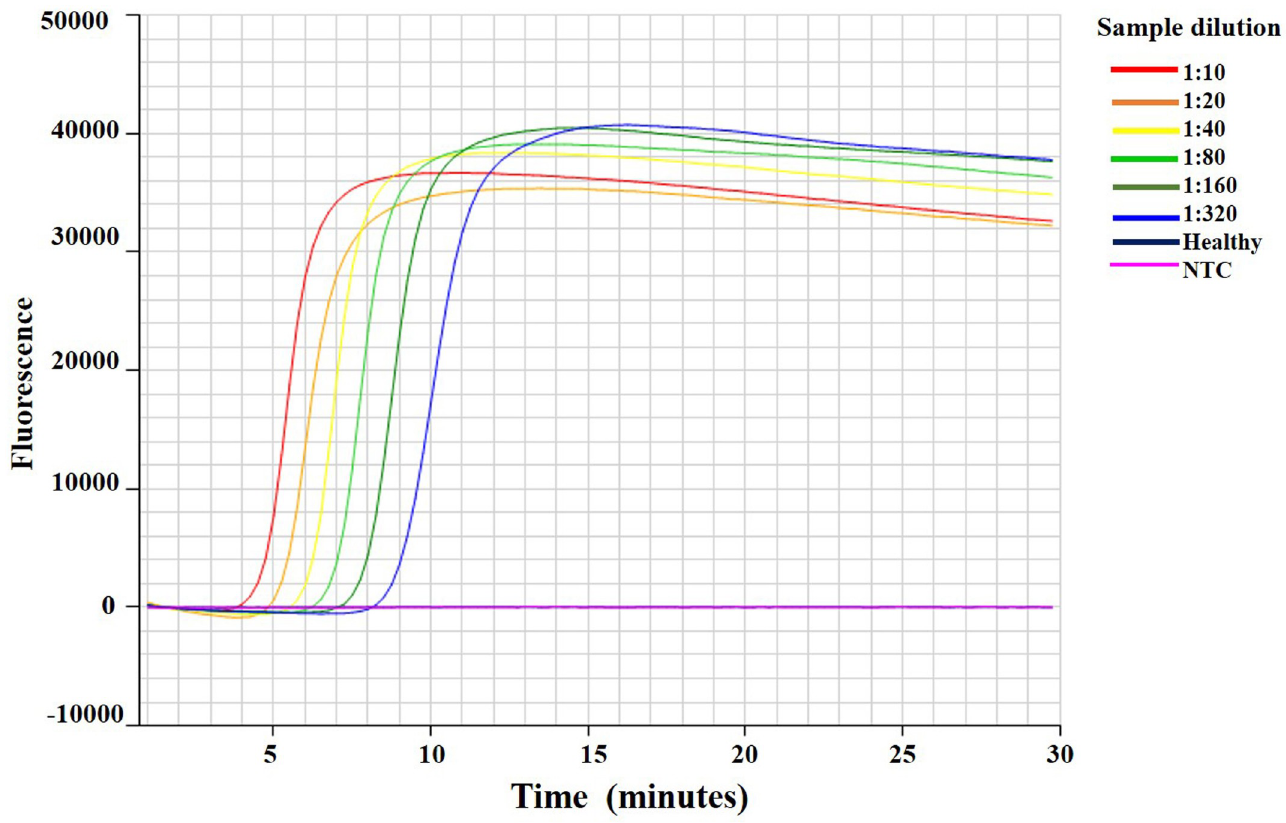
Fig 5. Optimization of Citrus tristeza virus infected leaf extract dilution for IC-RT-LAMP assay. Amplification curves IC-RT-LAMP assay of extracts from healthy citrus tissue and two-fold serially diluted (1:10 to 1:320) leaf extract from CA-VT-AT39 infected citrus shows VT detection times for VT were 5:12, 6:00, 6:38, 7:27, 8:27, and 9:49 (min:sec) at different dilution ratios of 1:10, 1:20, 1:40, 1:80, 1:160, and 1:320, respectively.